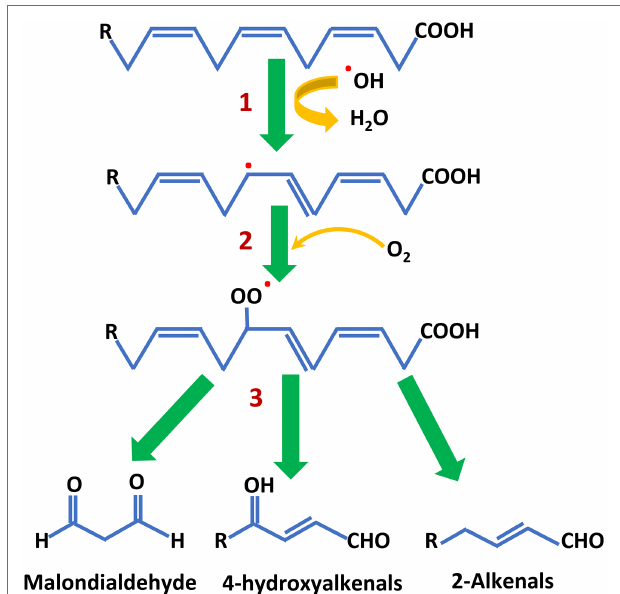
FIGURE 4 | An abbreviated scheme of PUFA oxidation that results in rancidity. 1. Reaction of the cis , cis -1,4-pentadiene structure with reactive oxygen species (shown here as the hydroxyl radical) produces a PUFA free radical. 2. Addition of molecular oxygen produces a peroxy radical. 3. Intramolecular rearrangements and further oxidation leads to chain cleavage and the production of a number of low molecular weight products. Note that the peroxy radical can abstract a proton from another PUFA molecule to propagate and accelerate PUFA